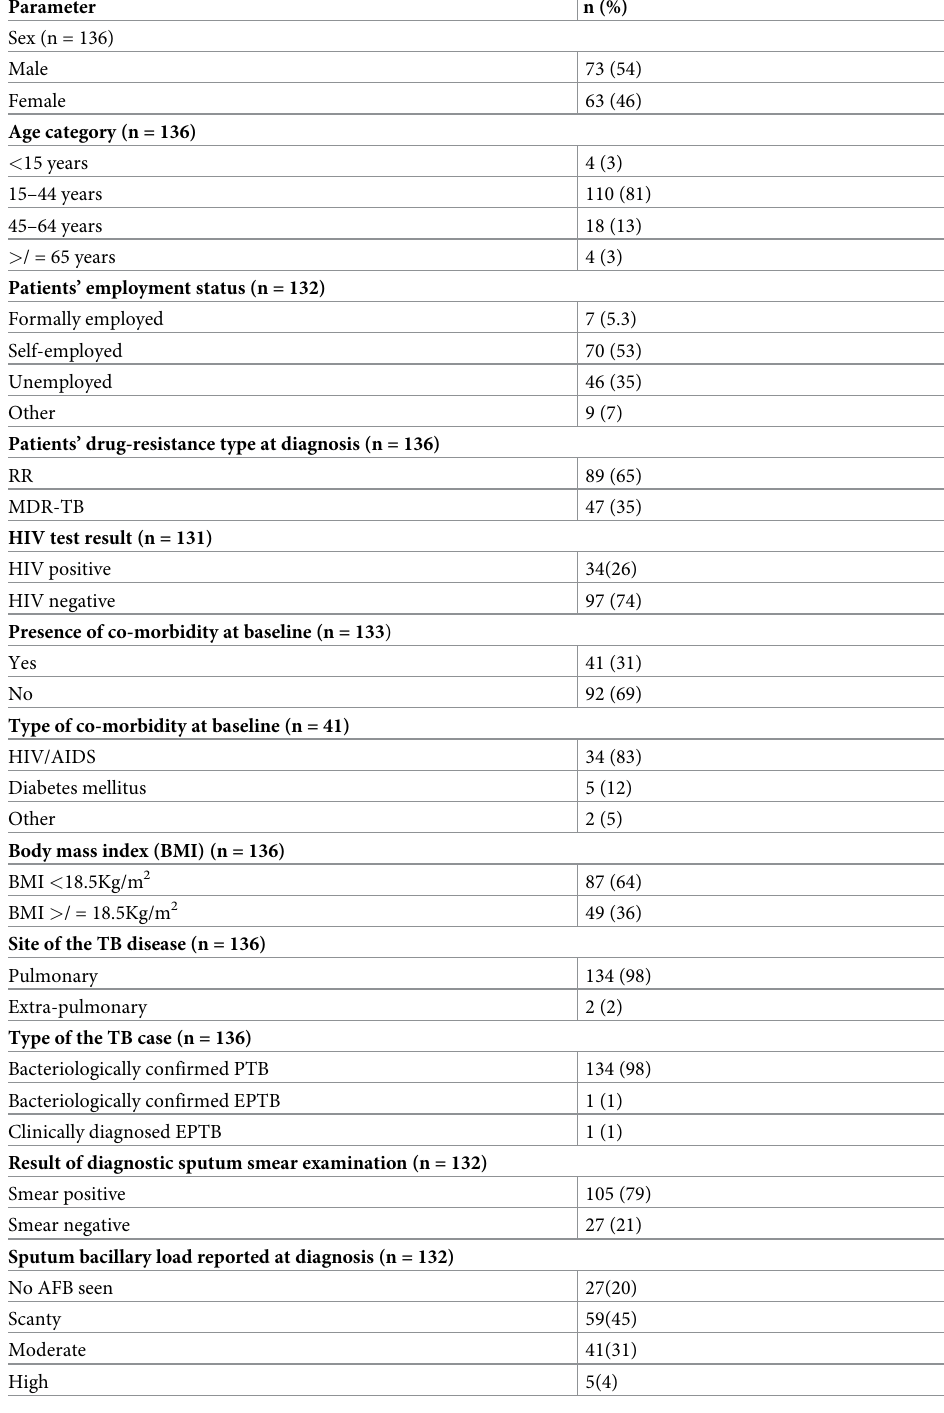
Table 1. Socio-demographic and clinical characteristic of study participants (n =